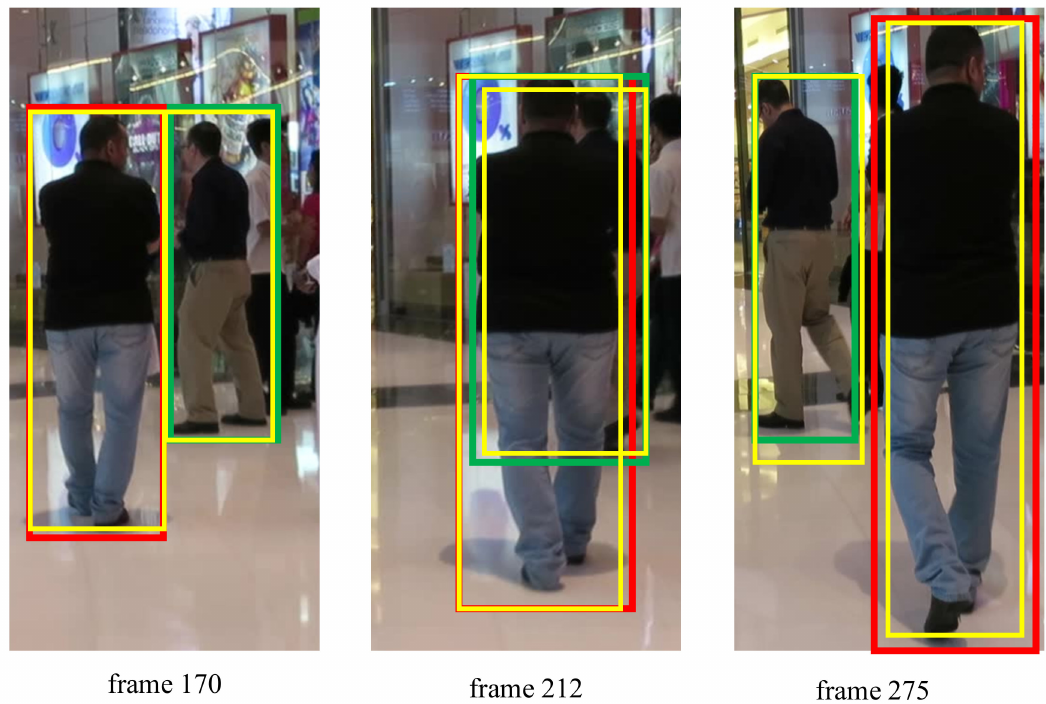
Figure 4. Examples of competitive trajectory tracking results, where yellow is the detection result, and red and green indicate the correct tracking